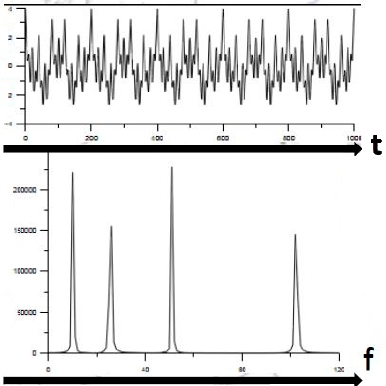
Figure 1. Exemplary signal and its transformation using the Fourier transform [4].